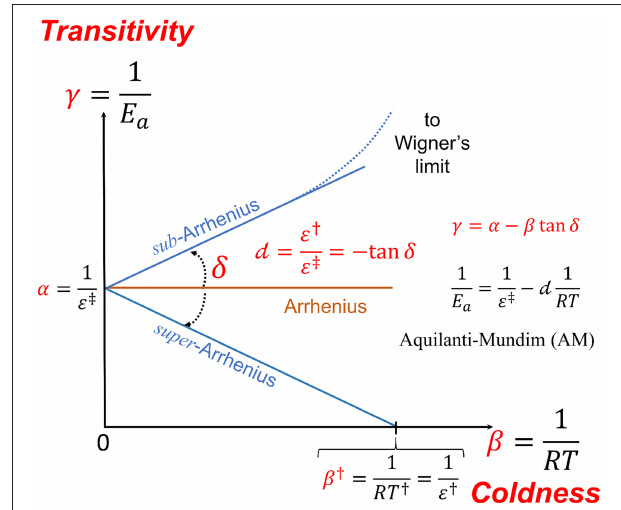
FIGURE 1 | The transitivity plane, γ = 1 E vs. β = 1 RT serves to give a a geometrical meaning to the phenomenological parameters occurring in the study of non-linear Arrhenius plots. The Arrhenius behavior is given as and corresponding to a line parallel to the β axis starting at α = 1 ε ‡ corresponds to a constant apparent activation energy E a . The well-known double dagger notation was introduced by Eyring (Eyring, 1935; Glasstone et al., 1941). Deviations from Arrhenius behavior gives to the γ function straight line dependence at small β a direction forming the δ angle, which it is connected to the d parameter of the Aquilanti-Mundim (AM) law. At low temperatures as the “coldness” variable β increases, the transitivity function tends to characteristic ultra-cold limiting values: (i) for d < 0 ( sub -Arrhenius) it tends to the Wigner limit and (ii) for d > 0 ( super -Arrhenius), γ , namely the = 0 : the β † propensity for reaction to occur, vanishes in β † , γ (cid:16) (cid:17) corresponding energy and temperature parameters are denoted by a single dagger, ε † and T † , respectively, as detailed